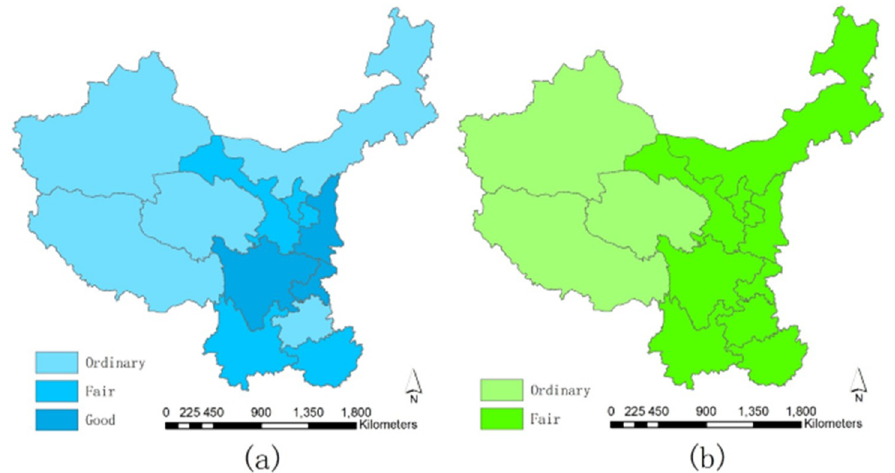
Fig 5. Average grades of performances. (a) Higher Education Subsystem; (b) Environmental Governance Subsystem.